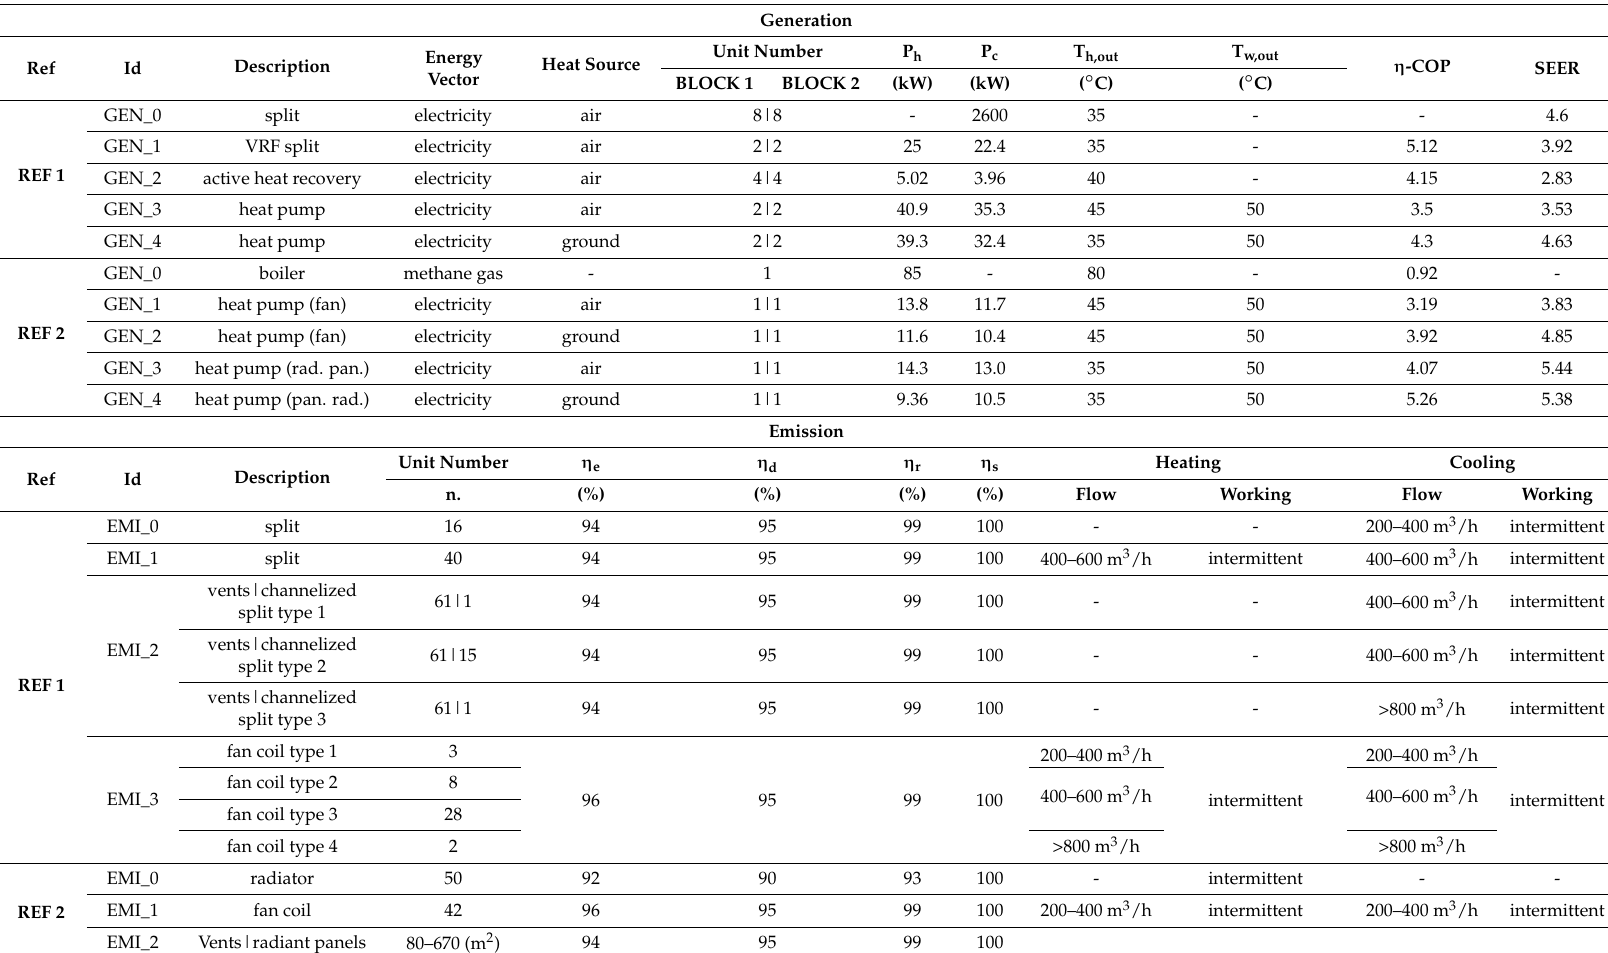
Table 5. Technical systems